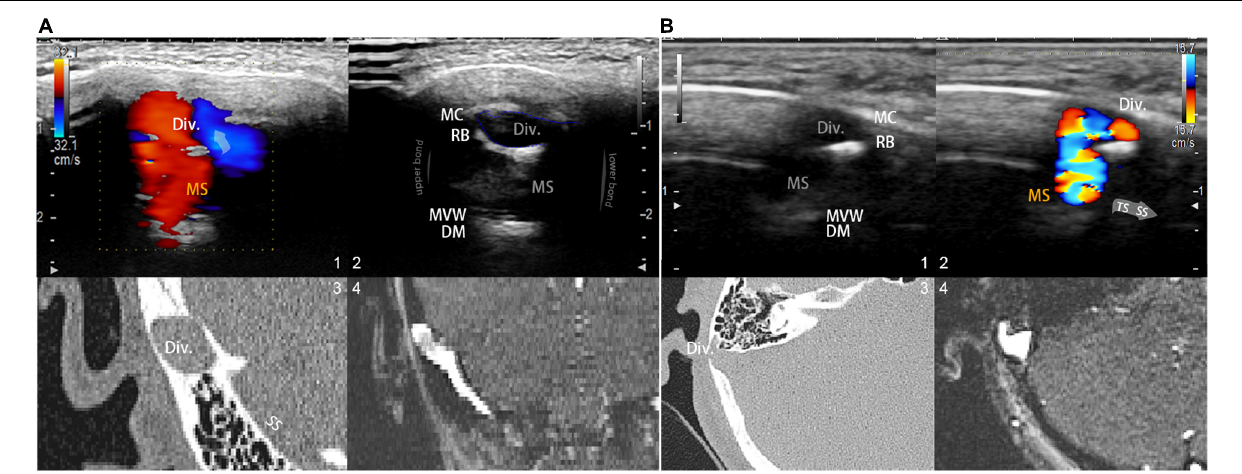
FIGURE 2 | Visualization and insights of the RCCD ultrasound method. ( A ; 1) Coronal RCCD continuous wave mode view of the mainstream sinus and diverticular flows. The transparent arrow indicates mainstream sinus flow diversion into the diverticulum. Div. indicates diverticulum; MS indicates mainstream sinus flow. (2) A 2D-planar cross-sectional view of the diverticulum and the mainstream sinus anatomical structures. MC indicates mastoid cortex; RB indicates the remnant mastoid bone; MVW indicates the medial vascular wall; and DM indicates the layers of dura mater. (3) Coronal CT view of the diverticulum and sigmoid sinus corresponding to the representative 2D ultrasonographic view. (4) Coronal 2D time-of-flight magnetic resonance imaging of the diverticulum and sigmoid sinus corresponding to the representative 2D ultrasonographic view. (B) A 2D-planar axial view of the diverticulum and mainstream sinus anatomical structures. MC indicates the mastoid cortex; RB indicates the remnant mastoid bone; MVW indicates the medial vascular wall; and DM indicates the layers of the dura mater. (1) A 2D-planar cross-sectional view of the diverticulum and mainstream sinus anatomical structures. MC indicates the mastoid cortex; RB indicates the remnant mastoid bone; MVW indicates the medial vascular wall; and DM indicates the layers of the dura mater. (2) Axial RCCD continuous wave mode view of the mainstream sinus and diverticular flows. The gray arrow indicates the flow direction from the transverse sinus to the sigmoid sinus. Div. indicates diverticulum; MS indicates mainstream sinus flow. (3) An axial CT view of the diverticulum and sigmoid sinus corresponding to the representative 2D ultrasonographic view. (4) Axial 2D time-of-flight magnetic resonance imaging of the diverticulum and sigmoid sinus corresponding to the representative 2D ultrasonographic